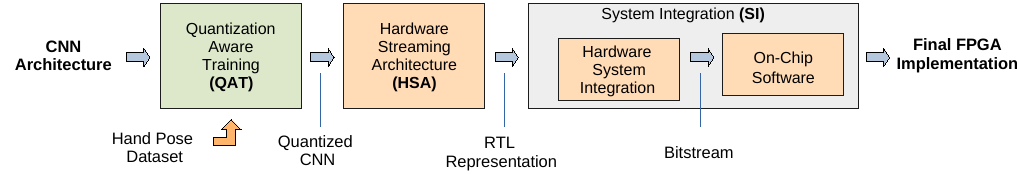
Figure 2. Design process overview; the first box illustrates the software-level design phase, while the other boxes illustrate the hardware related design phase. The first stage is quantization-aware training (QAT) in which we decrease the CNN memory demand as well as the computation time on the hardware. The second stage is hardware streaming architecture (HSA) where the underlying hardware structure is designed for the CNN. In system integration (SI) stage, the programmable logic PL and the processing system PS are brought together and the interface with the memory is configured through the hardware system integration sub-stage. Furthermore, the on-Chip Software is developed for preprocessing and interfacing with the